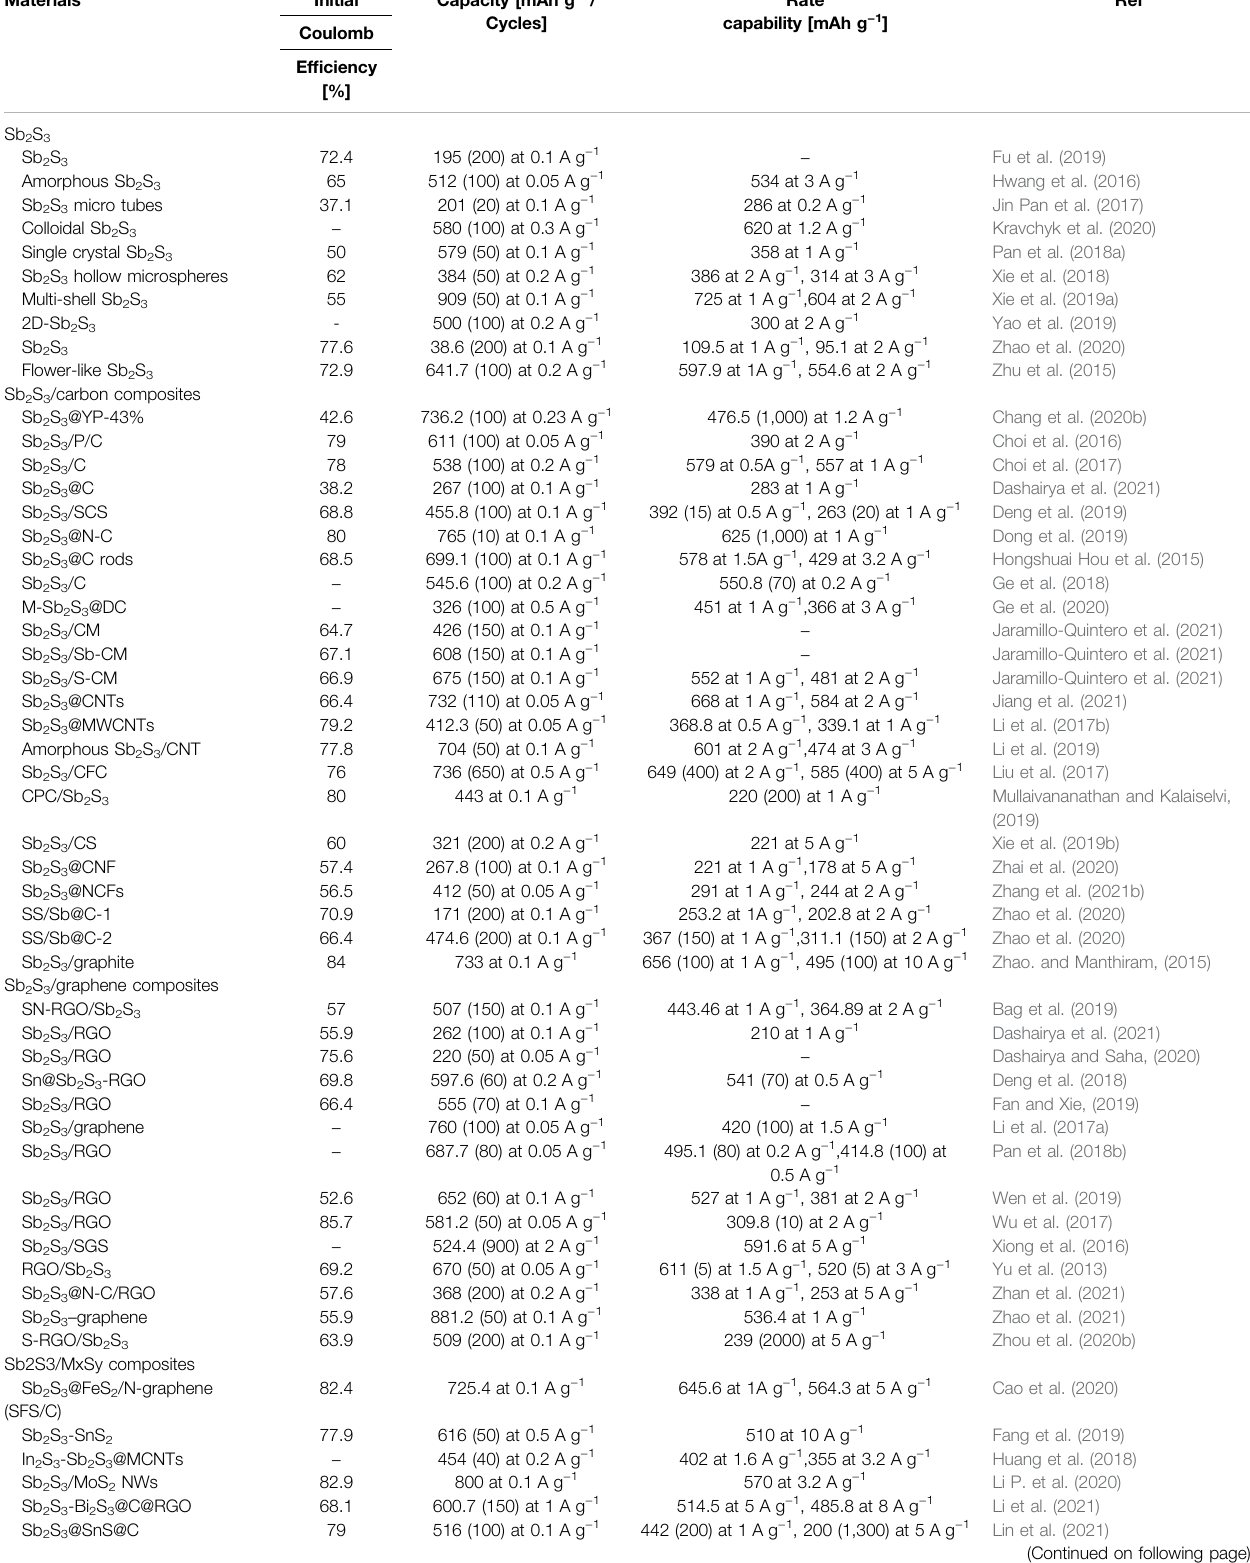
TABLE 1 | Electrochemical performances of Sb 2 S 3 -based nanomaterials as anodes for SIBs.